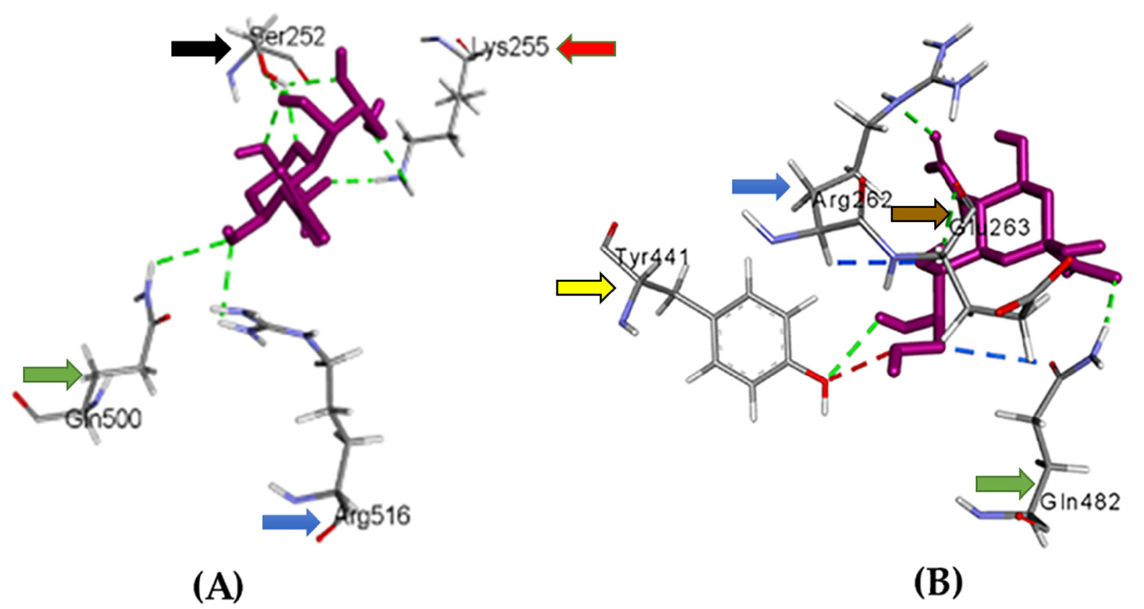
Figure 6. Sialic acid interacted with mutant ( A ) and wildtype ( B ) S1 proteins. Visualization of molecular docking outputs was performed by Discovery Studio. Ligand (sialic acid) was colored purple, while bond interactions were indicated with different colors. The green color refers to hydrogen bonds, blue color shows carbon-hydrogen bonds, and red color refers to acceptor hydrogen bonds. Residues of aa included in the interactions were indicated with an ID and three letters. Black arrow refers to serine, green arrow indicates glutamine, blue arrow shows arginine, red arrow refers to lysine, yellow arrow shows tyrosine, and brown arrow refers to glutamic Acid.